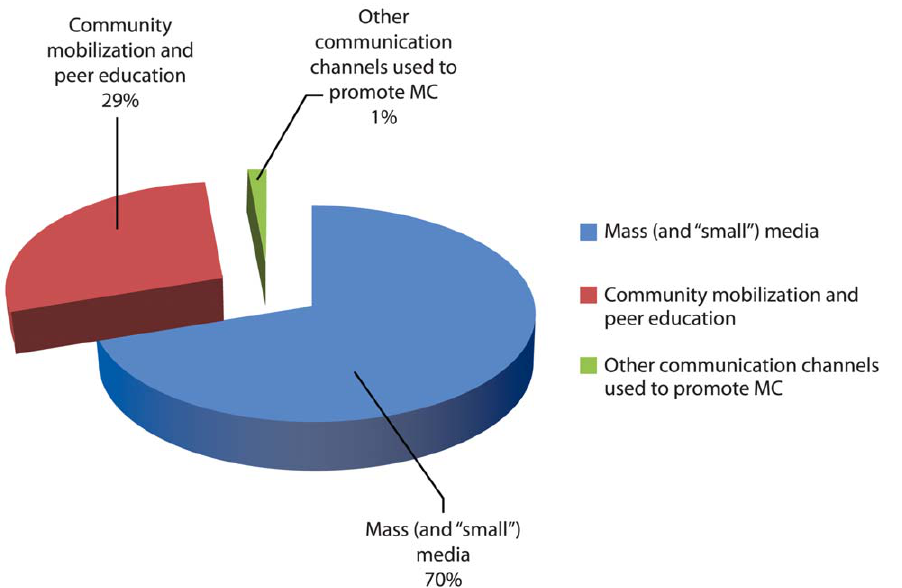
Figure 1. Percentage of budget for demand creation costs for Jhpiego VMMC campaigns in Iringa and Njombe Regions, Tanzania.